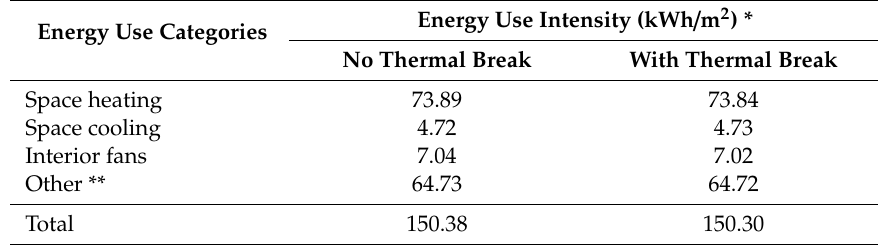
Table 5. The annual energy use intensity and energy cost for the case study